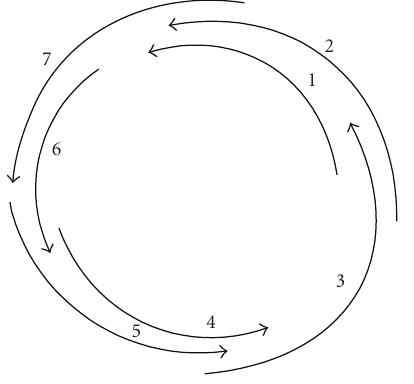
Figure 8: Example of a set of circular arcs G .